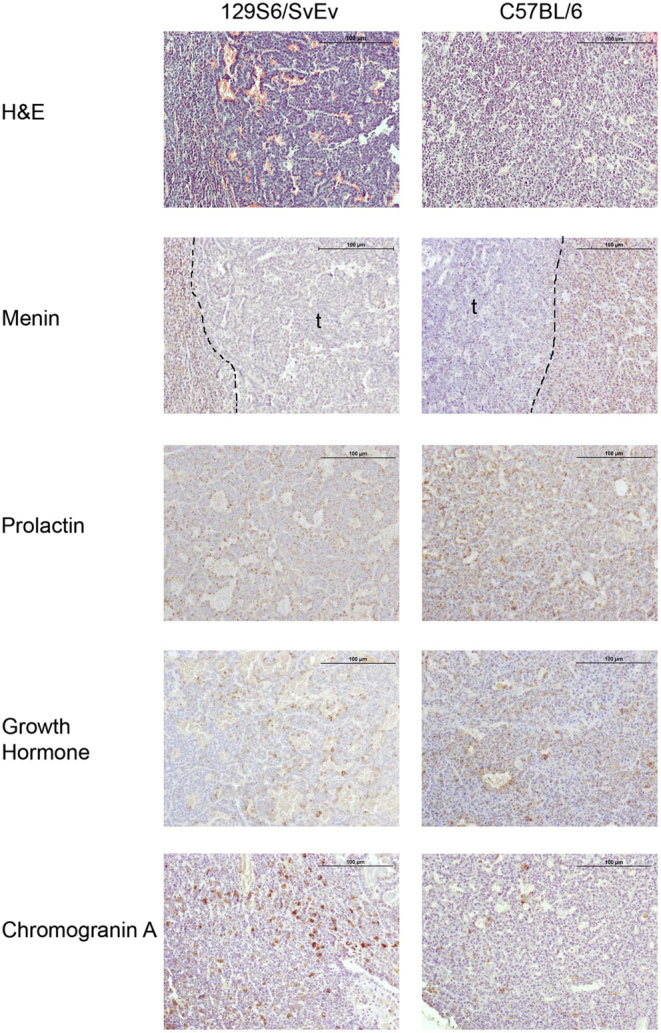
Histological and immunohistochemical analysis of anterior pituitary tumours in congenic Men1+/- mice. Serial sections of anterior pituitary adenomas from 18-month-old Men1+/- 129S6/SvEv and C57BL/6 mice were stained with haematoxylin and eosin (H&E) and for menin, prolactin, growth hormone and chromogranin A, which is a neuroendocrine secretory protein (44). Menin expression was lost within the pituitary adenomas (t), whereas prolactin, growth hormone and chromogranin A, identified by brown DAB staining, were all expressed within cells of the anterior pituitary adenomas in both mouse strains. These findings indicate that the tumours are adenomas originating from the anterior pituitary and that they are associated with loss of menin expression. The scale bar represents 100 μM.